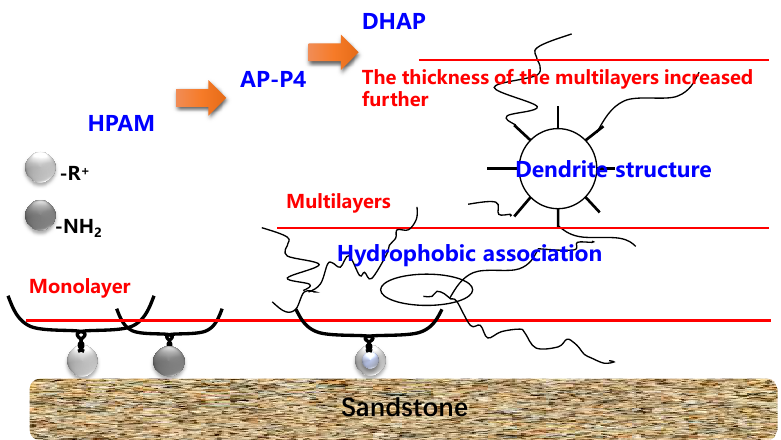
Figure 13. Adsorption characteristics of the polymer. Table 6. Effect of movement speed on polymer adsorption